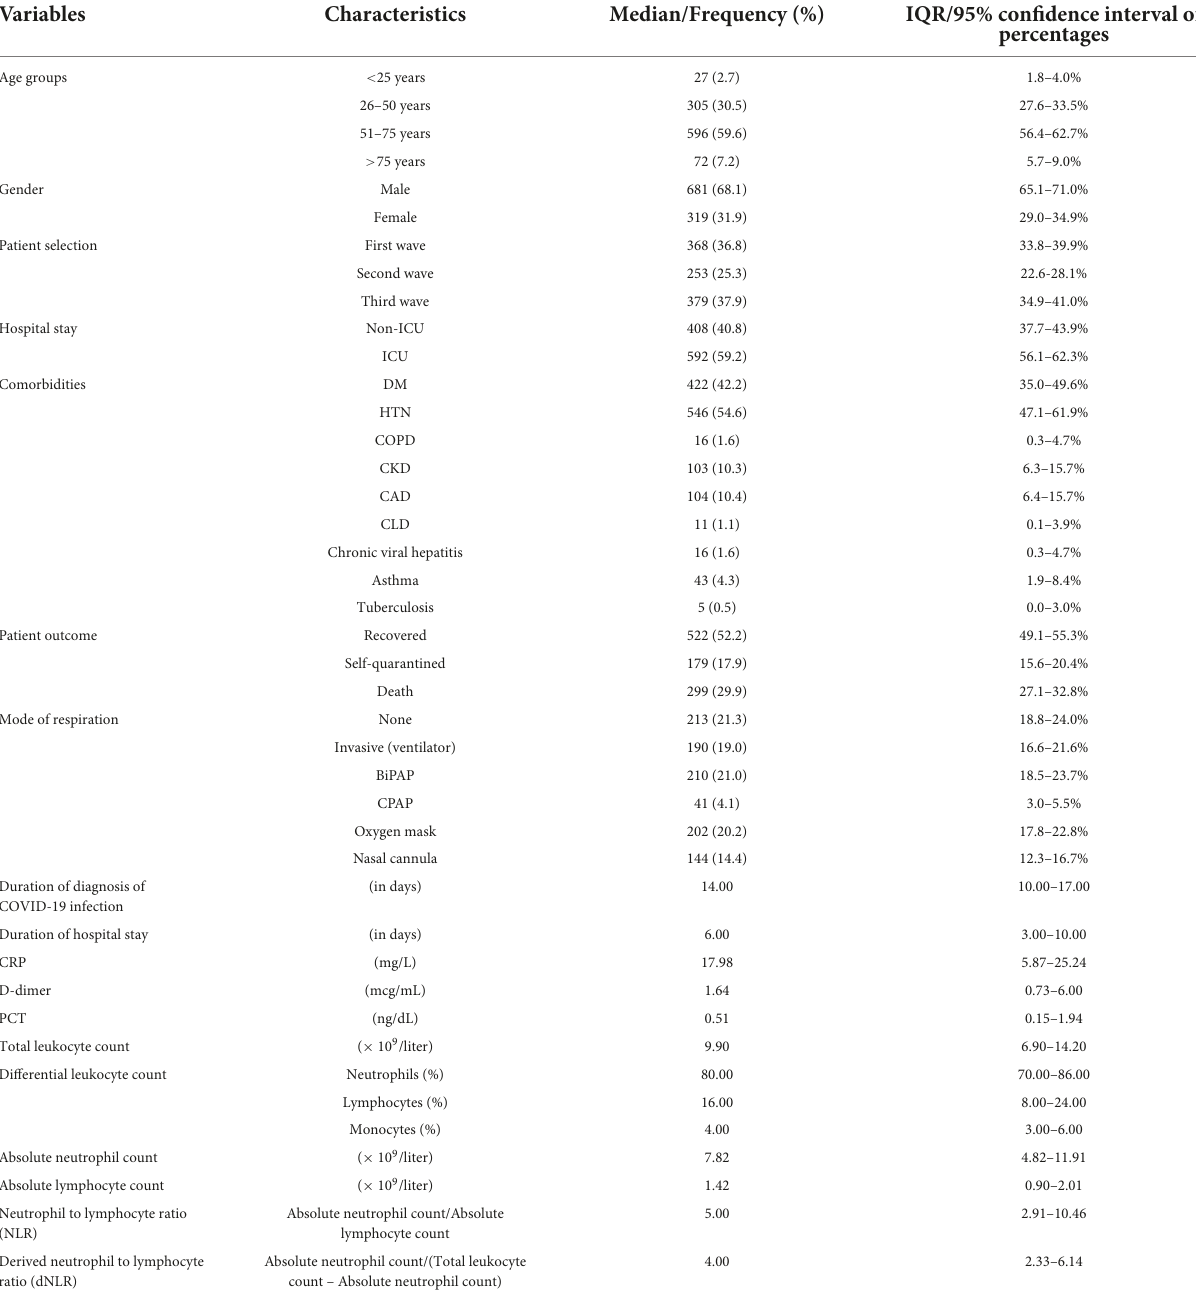
TABLE 1 Baseline data of the study subjects ( n =